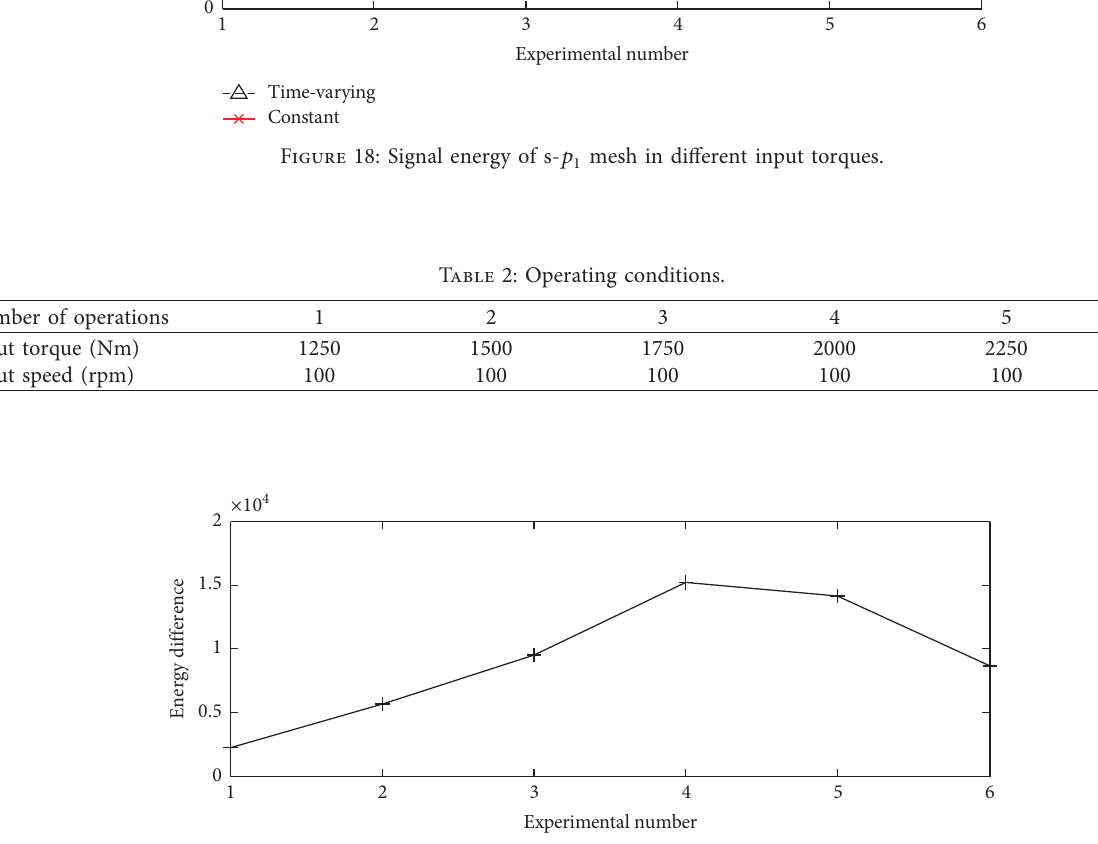
Figure 19: Signal energy difference between constant and time-varying conditions of s- p